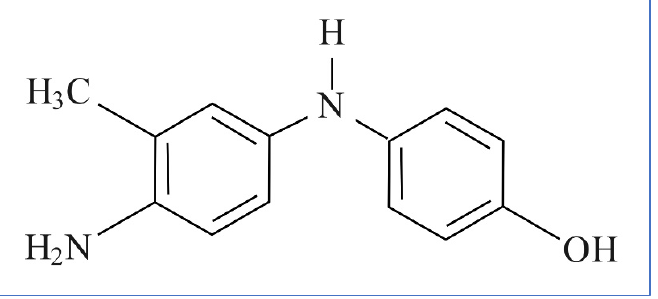
Figure 11. Structure of the sulfur blue 7.